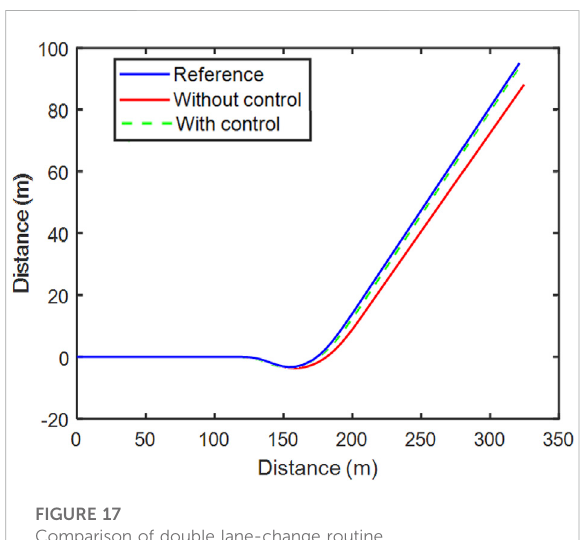
FIGURE 17 Comparison of double lane-change